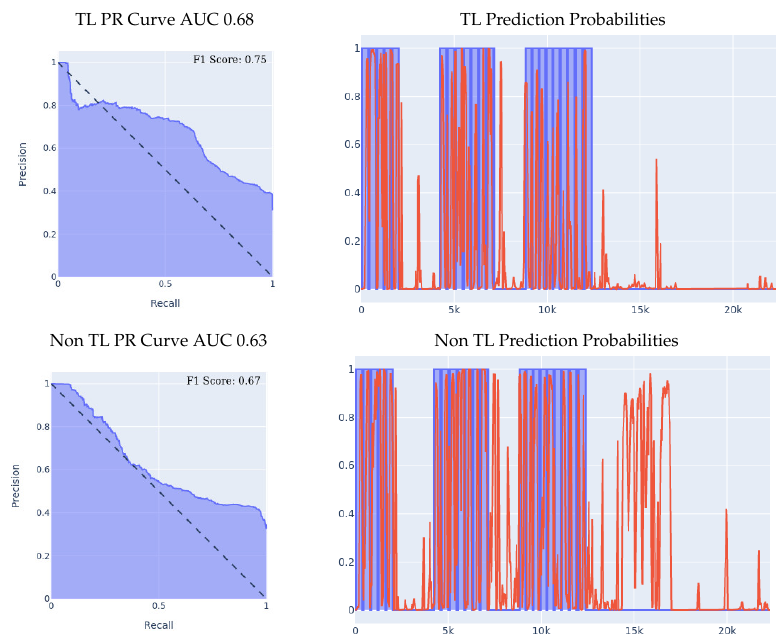
Figure 11. Real-life test experiment. For prediction probabilities, the x axis is the time, the y axis is the prediction threshold, the blue data is the real labels, and the red data is the prediction